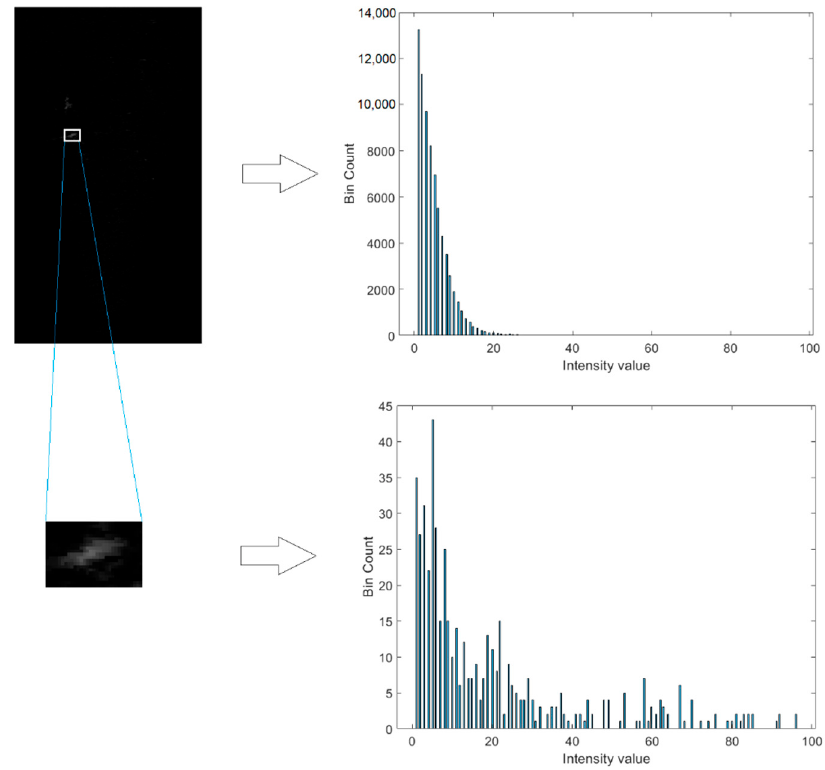
Figure 4. A comparison of histograms, from the entire image frame to a small region encompassing an identified target object (pixel values with intensity equal to 0 are excluded from the calcula- tions).